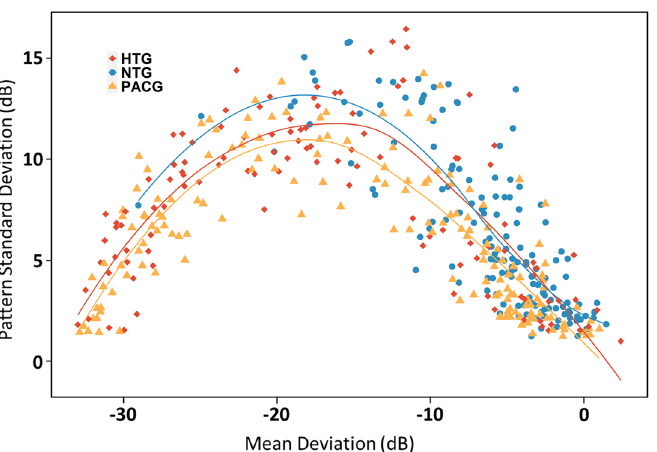
Figure 4. Scatterplot of PSD versus MD for eyes with PACG, HTG, and NTG. Lines represent best-fit quadratic functions for each group. Yellow triangles represent PACG eyes; red squares represent HTG eyes; blue circles represent NTG eyes. Image was generated using “R” software (R version 4.0.2, http:// www.r- proje ct.